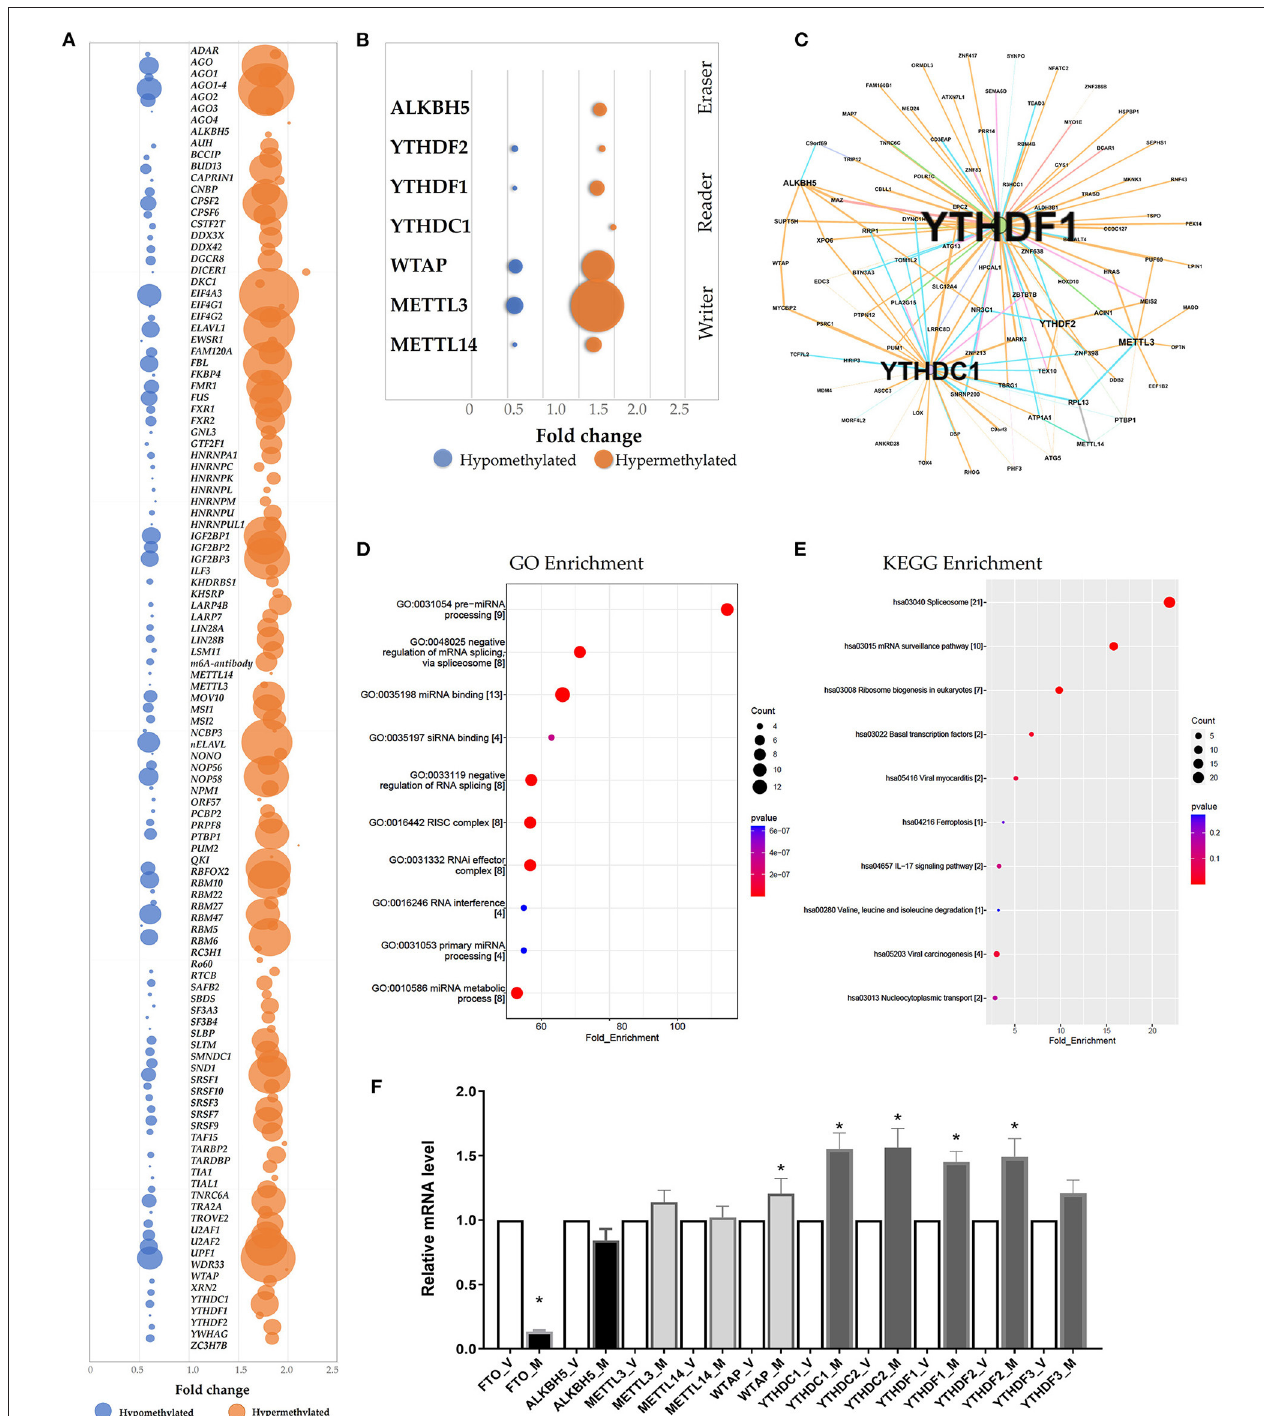
FIGURE 4 | Prediction and function of RNA-binding proteins (RBPs) for N 6 -methyladenosine (m 6 A) methylation. (A) Bubble chart represented as the binding rates of the 140 RBPs. Values were displayed as the differentially methylated mRNAs based on log2(FC). The number of genes binding to the RBPs by prediction was presented by bubble size. (B) Bubble chart showing the binding rates of the known m 6 A readers (YTHDF1, YTHDF2, YTHDC1), m 6 A writers (WTAP, METTL3, METTL14) and eraser ALKBH5 by prediction. (C) Network mapping showing the genes binding to the m 6 A readers, writers and erasers by prediction. (D,E) Enrichment analyses of Gene Ontology (GO) and Kyoto Encyclopedia of Genes and Genomes (KEGG) of the 215 candidate RBP genes. (F) Real-time PCR confirmed the mRNA levels of m6A readers (YTHDC1, YTHDC2, YTHDF1, YTHDF2, YTHDF3), erasers (FTO and ALKBH5) and writers (WTAP, METTL3, METTL14).